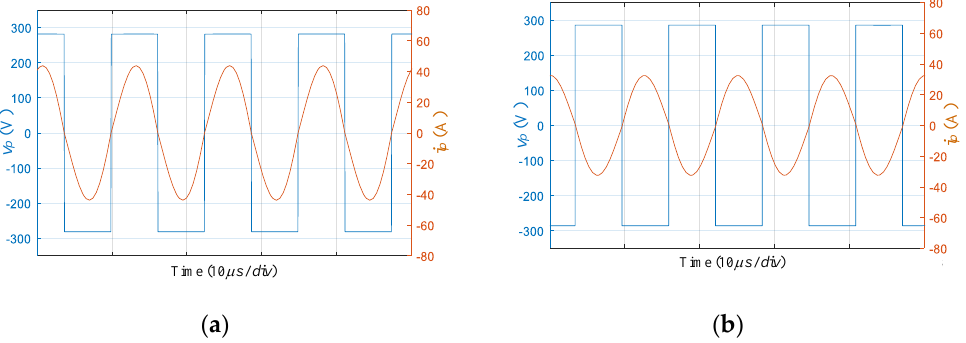
Figure 11. v s and i s in ( a ) the forward direction and ( b ) the reverse direction.